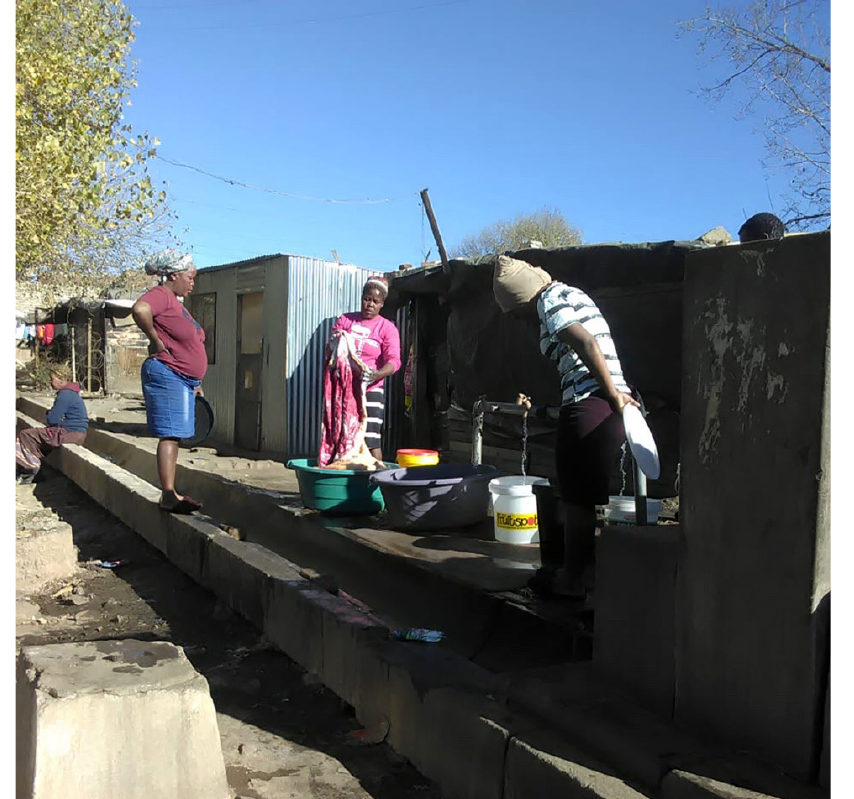
Figure 2. The family of one of the female heads of household from Denver draws water from a communal tap to do laundry, next to a water trough built after a serious fire. Source: Photo by participant D6,